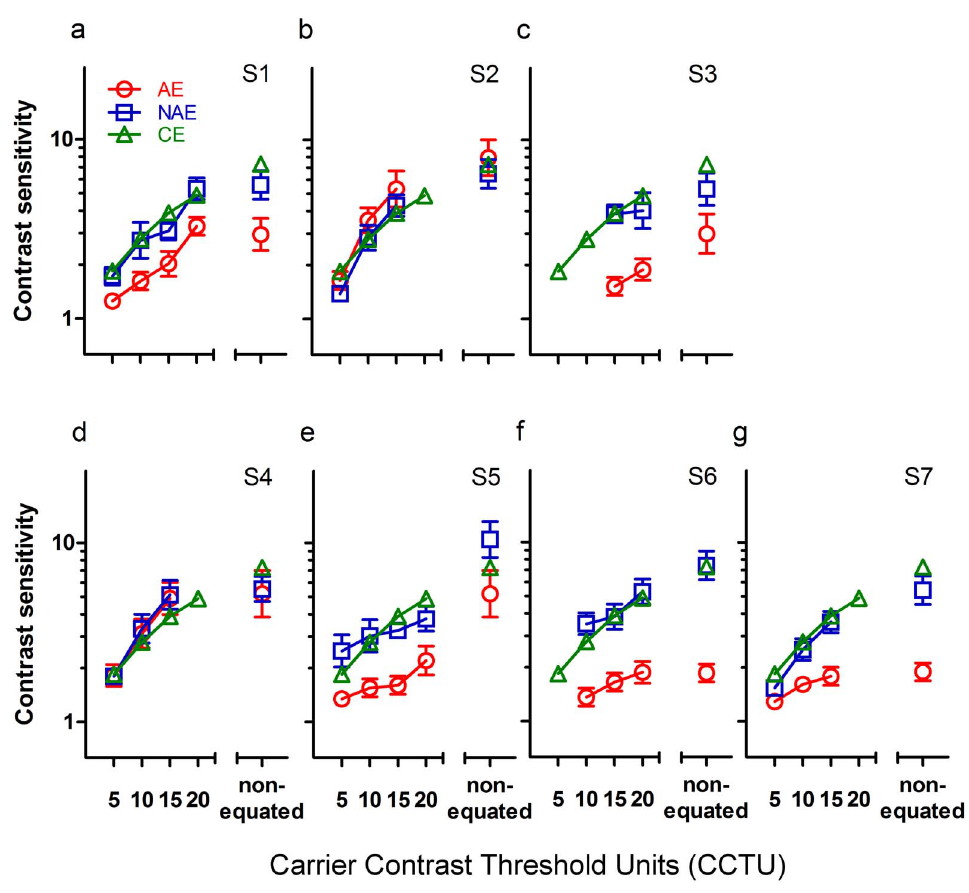
Figure 5. Contrast sensitivity for second-order motion at all carrier contrast levels for each amblyopic subject. The data points for control eyes (CE, Triangles) were averaged across subjects and temporal frequencies. While the data points for amblyopic eyes (AE, Circles) and non- amblyopic eyes (NAE, Squares) were only averaged across temporal frequencies. Note that for some subjects (S3 and S6) the sensitivity for second- order motion could not be measured at some low carrier contrast levels because of the floor effect. And for some other subjects (S2, S4 and S7) the data could not be measured at the highest carrier contrast levels because in this condition the expected contrast of the noise carriers is larger than 1. Error bars represent one standard error of the mean.